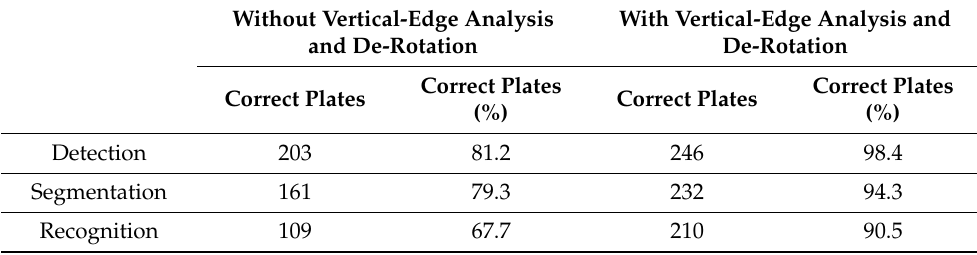
Table 5. A component-level performance comparison between the old and improved ALPR systems using the European-standard plates (500